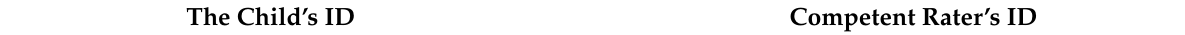
Table A1. The Observation Scale of Child’s behaviour in Interaction with a